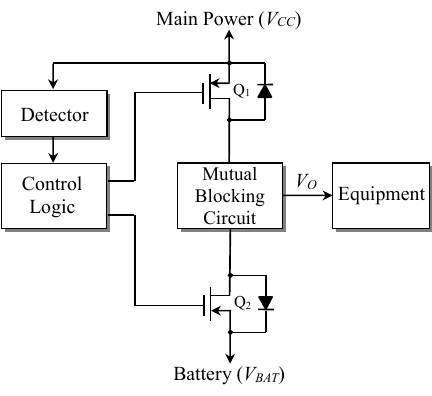
Figure 6. Proposed switching architecture using mutual blocking. Energies 2019 , 12 , x FOR PEER REVIEW